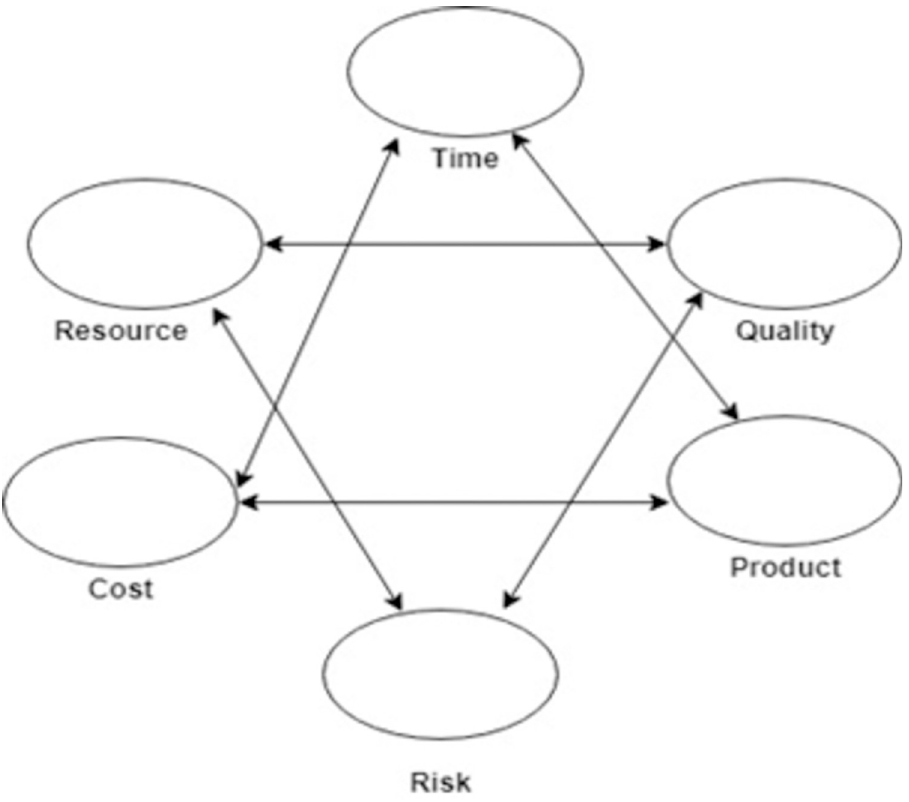
Fig 2. Six-pointed star framework of project management body of knowledge